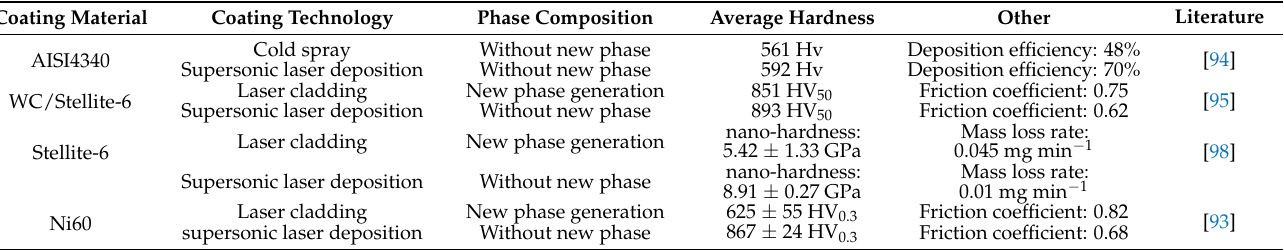
Table 5. Performance comparison of coatings prepared by different technologies.